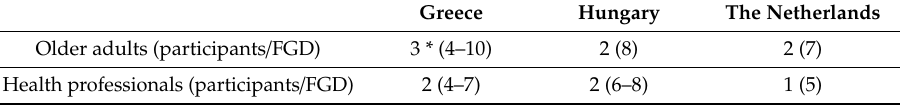
Table 1. Number of focus group discussions (FGDs) and participants in the three countries.